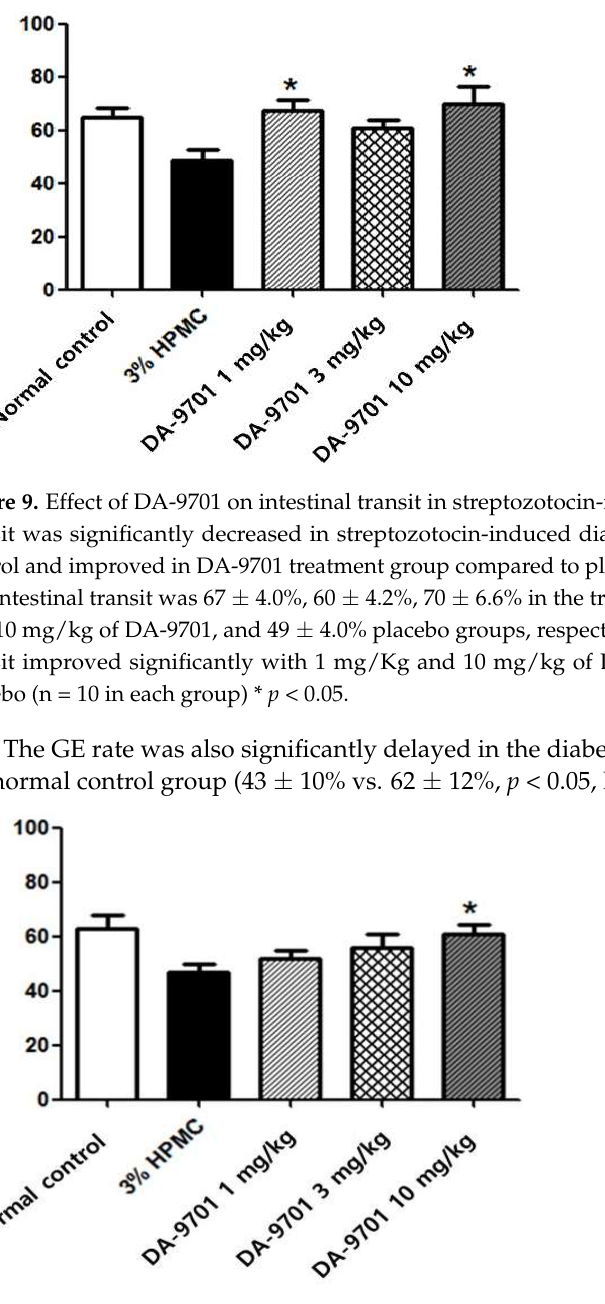
Figure 8. Effect of DA-9701 on colonic motility in normal control and streptozotocin-induced dia- betic mice. DA-9701 administration showed a dose-dependent increase in the amplitude of sponta- neous phasic contractions in the colon in normal controls and streptozotocin-induced diabetic mice, without significant difference between the two groups. (n = 10 in each group).